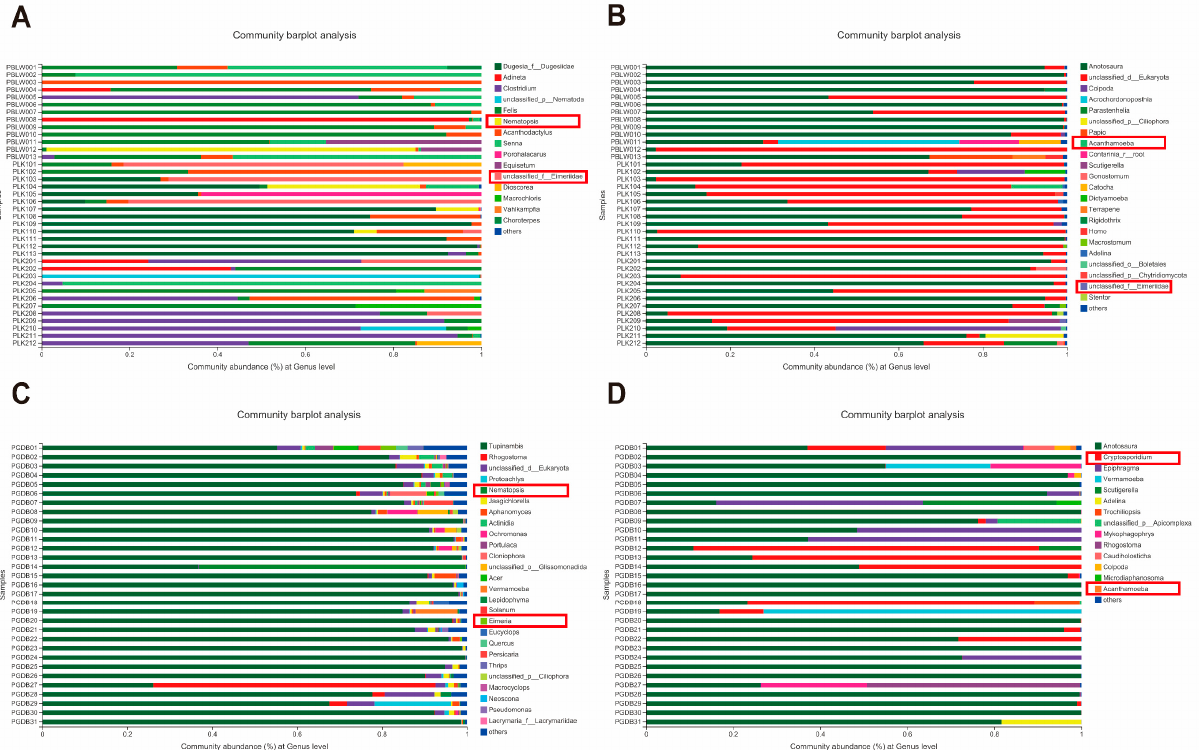
Figure 2. Composition of parasites in each sample at genus level. Different colors indicate different groups, with details shown on right sides of each figure, respectively. ( A , B ) show composition of parasites in Luokeng and Beilou. ( C , D ) show composition of parasites in Gandong. Parasites discovered in the current study are contained within rectangle. Table 1. Parasitic infection of crocodile lizards at different sampling